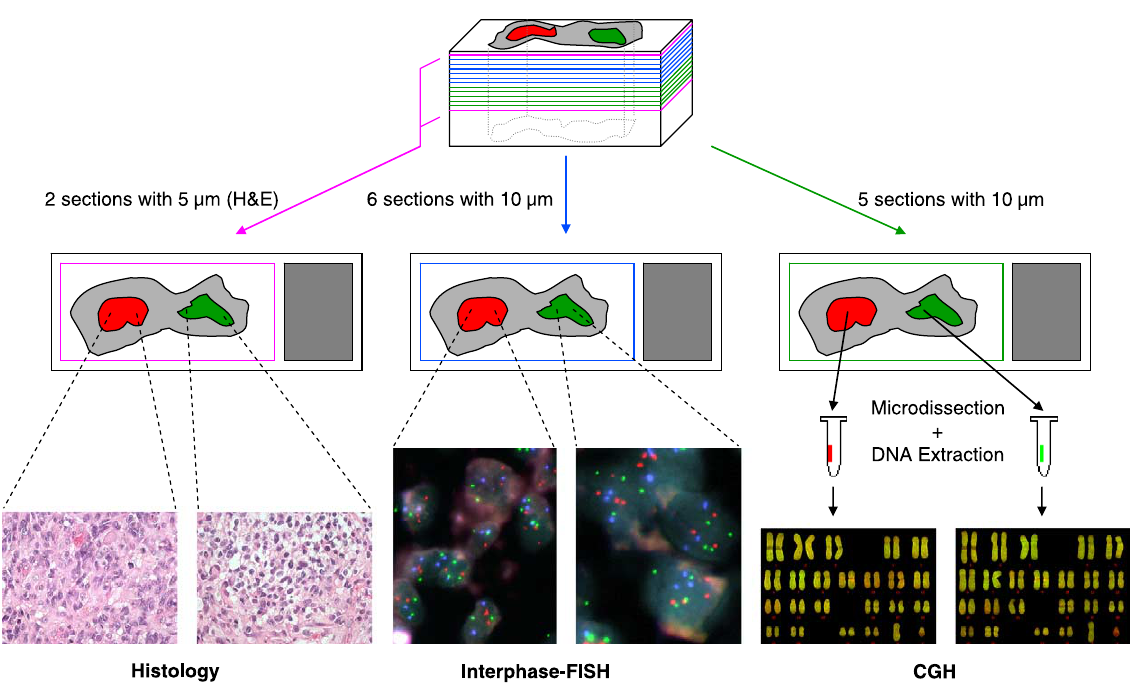
Fig. 2. Overview of the strategy of the project. Paraffin-embedded tumor material (indicated in grey on the glass slides) was cut in the following order: First one H&E-stained section (violet arrow and lines) was made to check if the two different tumor parts, the “astrocytic” (indicated in red), and the “oligodendroglial” (indicated in green), were still available. Hereupon six 10-µm-thick sections (blue arrow and lines) were cut for Interphase-FISH and the two different tumor areas according to the histology were evaluated separately. Five consecutive 10-µm-thick sections (green arrow and lines) were prepared for DNA extraction for the CGH analysis. “Astrocytic” and “oligodendroglial” tumor parts were microdissected with a needle under a light-microscope and DNA was extracted separately. Finally, one H&E-stained section was evaluated again to control that both tumor parts were still